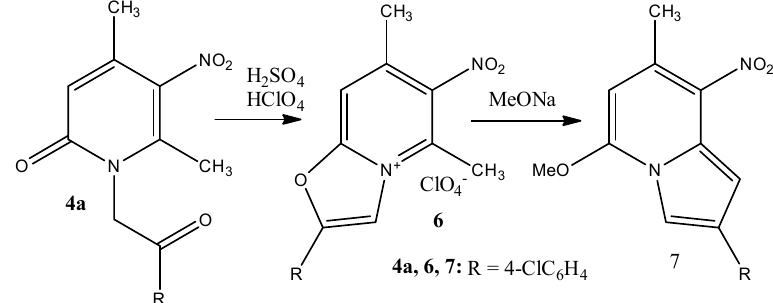
Scheme 5. Closure of oxazolium ring in N-phenacylpyridone and further